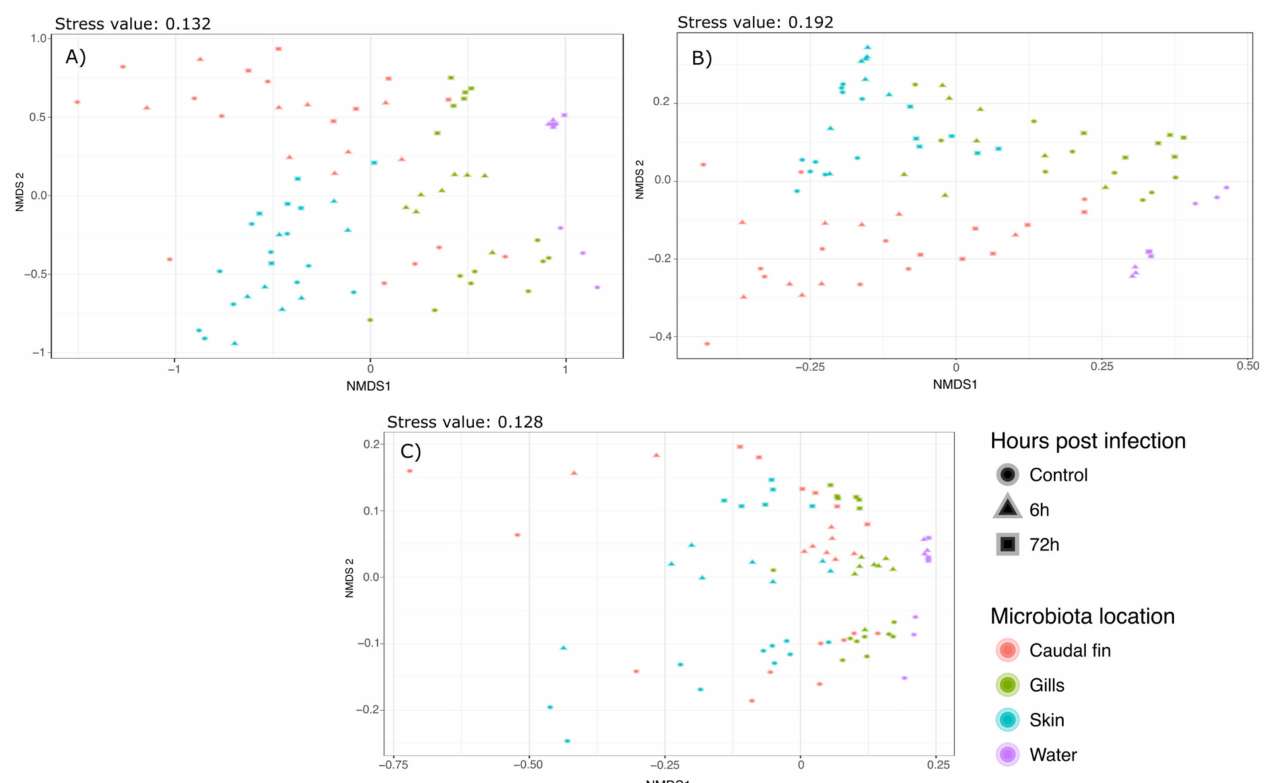
Figure 2. Nonmetric multidimensional scaling clustering microbial communities based on ( A ) Bray– Curtis, ( B ) Weighted, and ( C ) Unweighted Unifrac distances. The samples were clustered following this: circles represent the control condition, triangles represent the 6 h post-infection condition, and the squares represent the 72 h post-infection condition. Samples were also colored by the microbiota location (blue: skin microbiota; red: fin microbiota; green: gills microbiota; and purple: bacterial community of the